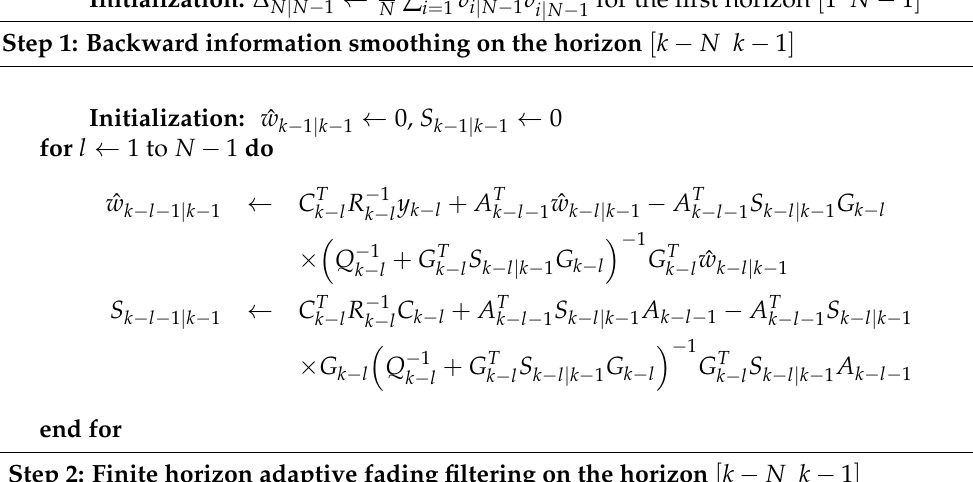
Algorithm 1 The AFMRH filtering